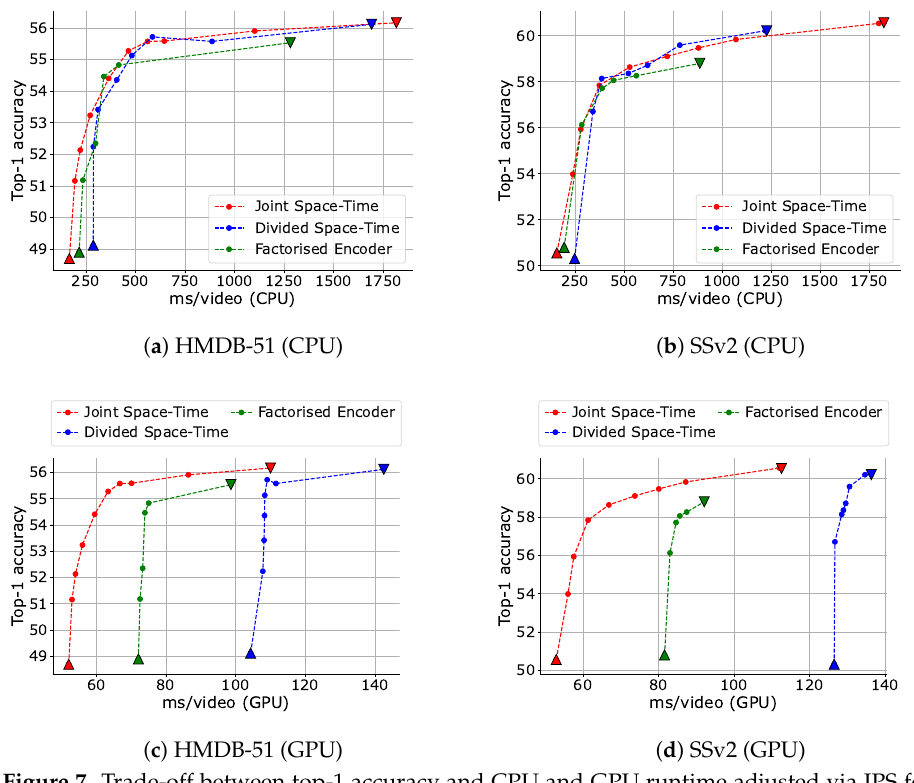
Figure 7. Trade-off between top-1 accuracy and CPU and GPU runtime adjusted via IPS for each attention type of TimeSformer. The runtime includes those of the model’s inference and video decoding, and video decoding was always run on a CPU. ”ms” stands for milliseconds. We used AMD Ryzen 9 3900X 12-Core Processor as CPU and NVIDIA GeForce RTX 3090 as GPU. An input clip has 24 frames with a frame size of 144 × 144 and 6 fps. The data point with the highest runtime for each setting is when no input reduction is performed (upper bound), and the data point with the lowest runtime is when only I-frames are input (lower bound). The upper and lower bounds are plotted as inverse triangles and triangles, respectively.